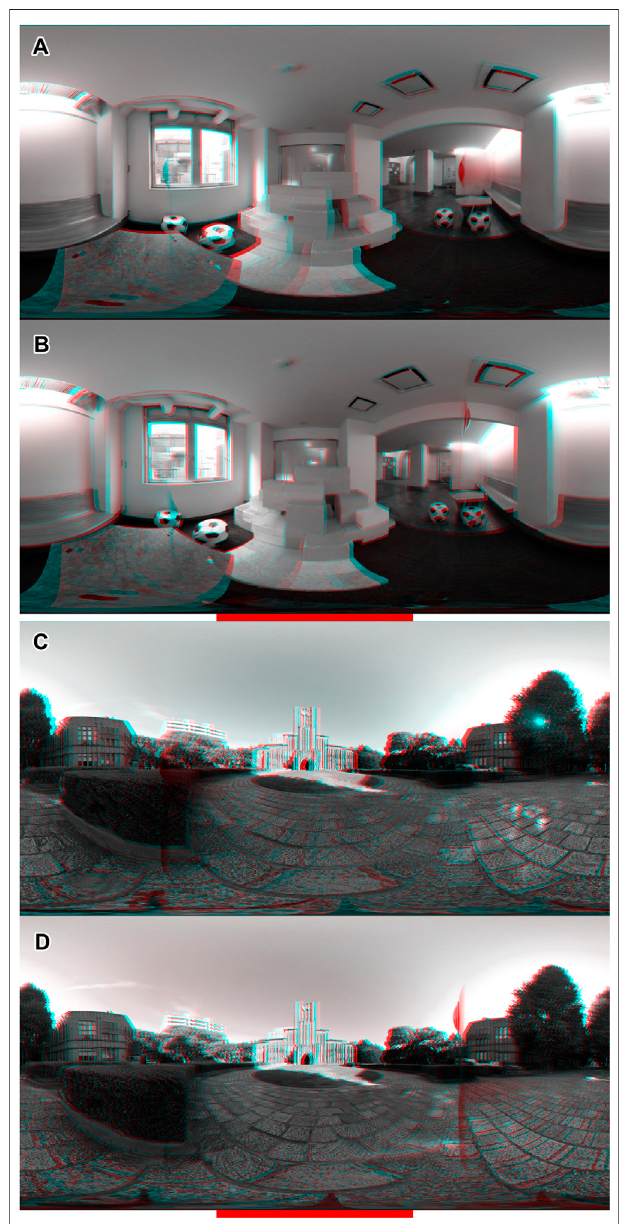
FIGURE 10 | Visual stimuli for experiment 1. Still stereo photos in equirectangular formatcapturedbythe same TeleParallax con fi guration when tilting the head 0 ° (A,C) or 30 ° (B,D) in the roll direction, converted into gray anaglyphic stereo. The red horizontal bar on the bottom indicates the fi eld of view of the HMD (120 ° ). The red (or blue) vertical stripes which appearedoutofthe fi eldofviewweretheomnidirectionalcamera takenbythe other